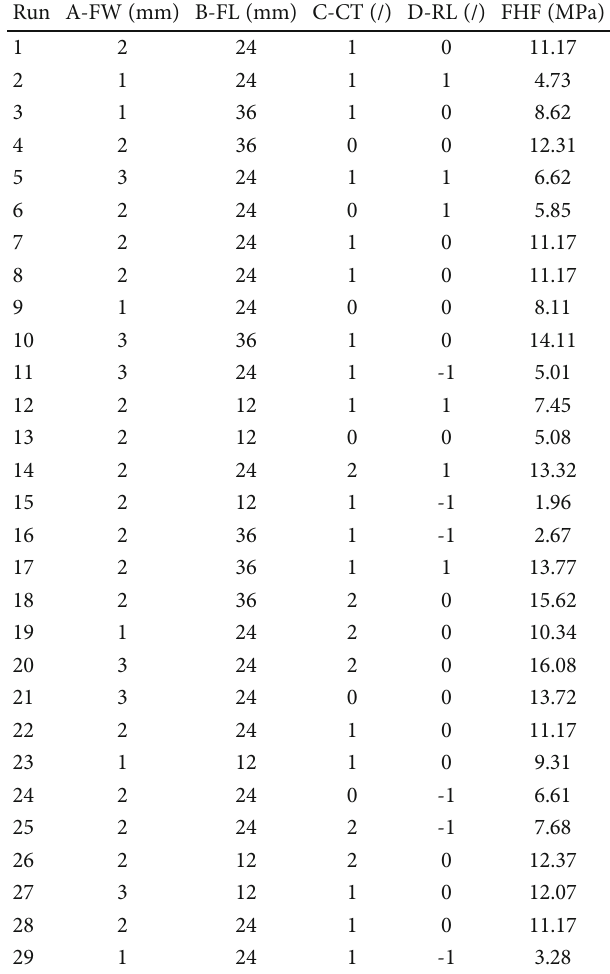
Table 2: Design of the Box-Behnken design table for frost heaving force